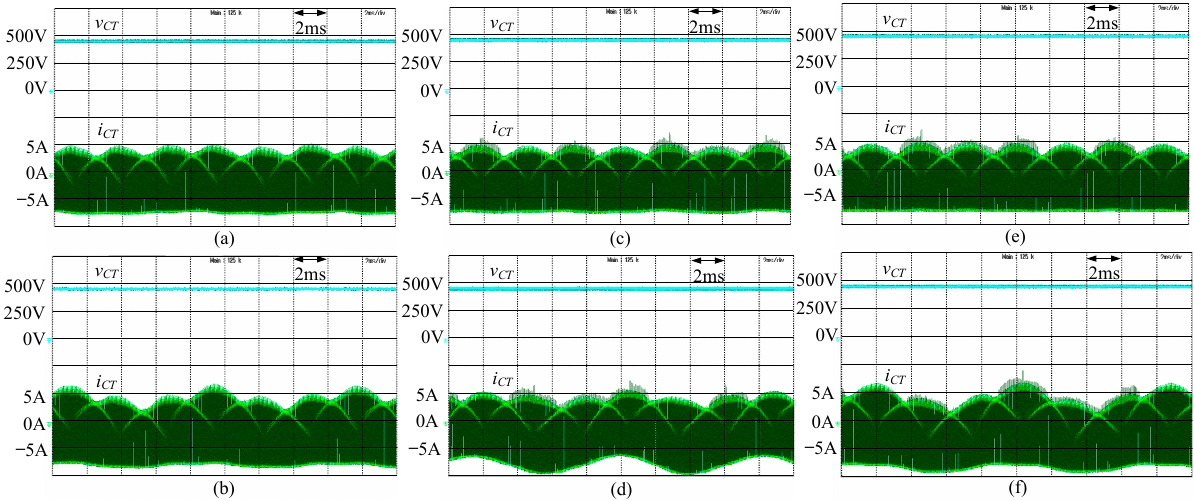
Figure 11. The simulated waveforms of the low-voltage-side dc current i Ldc and the testing capacitor current i CT for ( a , c ) balanced and ( b , d ) unbalanced load conditions in the ( a , b ) conventional down-scale voltage rating evaluation system, and the ( c , d ) proposed down-scale voltage rating evaluation system.